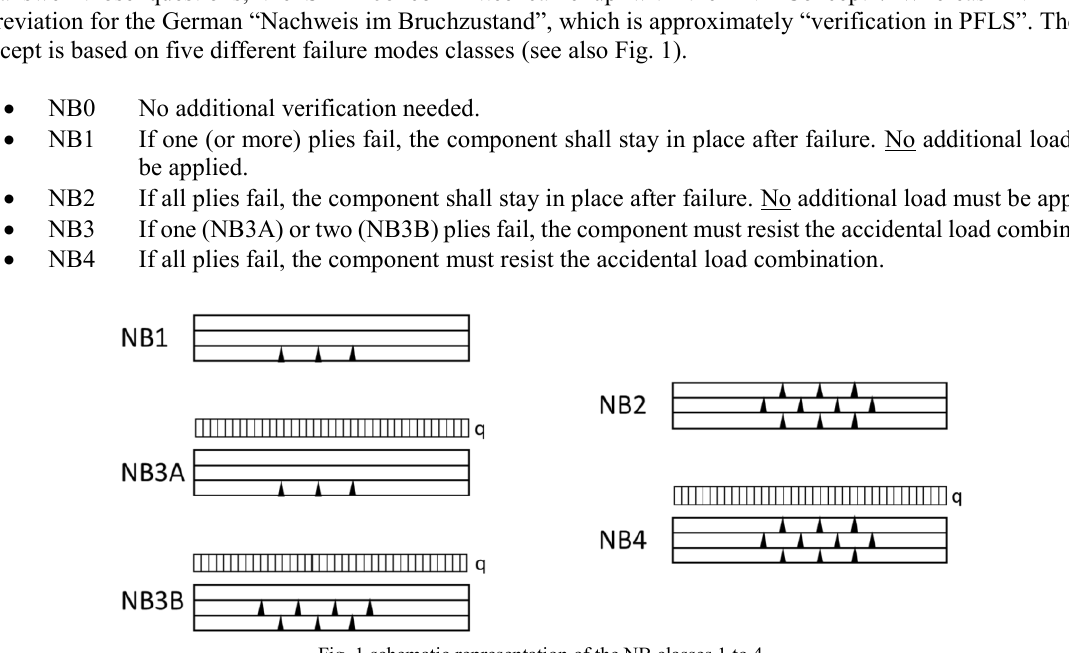
Fig. 1 schematic representation of the NB classes 1 to